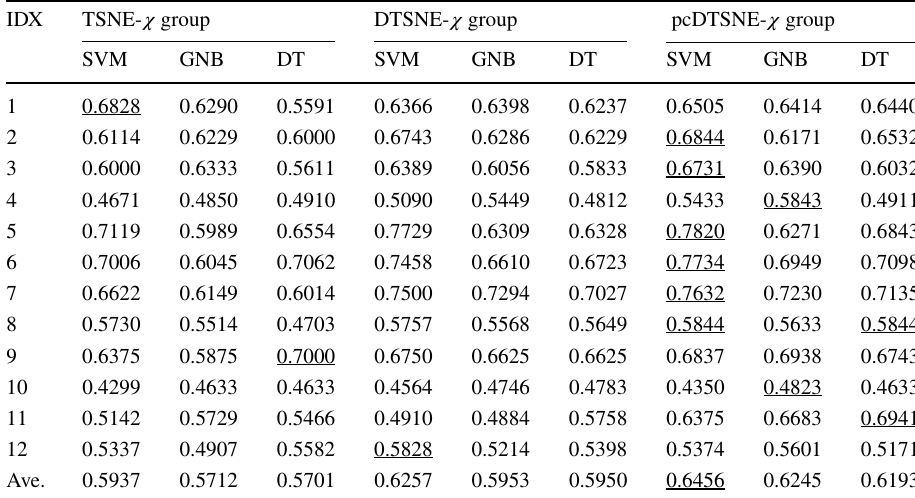
Table 5 Performance (f-score) comparison of TSNE- 𝜒 group, DTSNE- 𝜒 group classification task over 12 datasets, and the highest